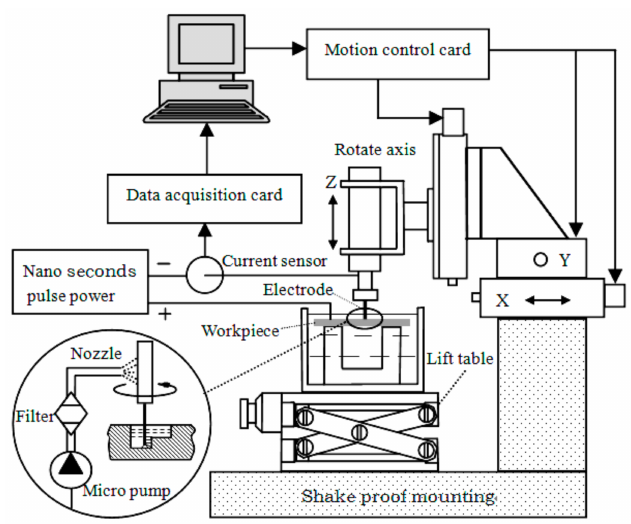
Figure 4. Schematic of the entire EMM